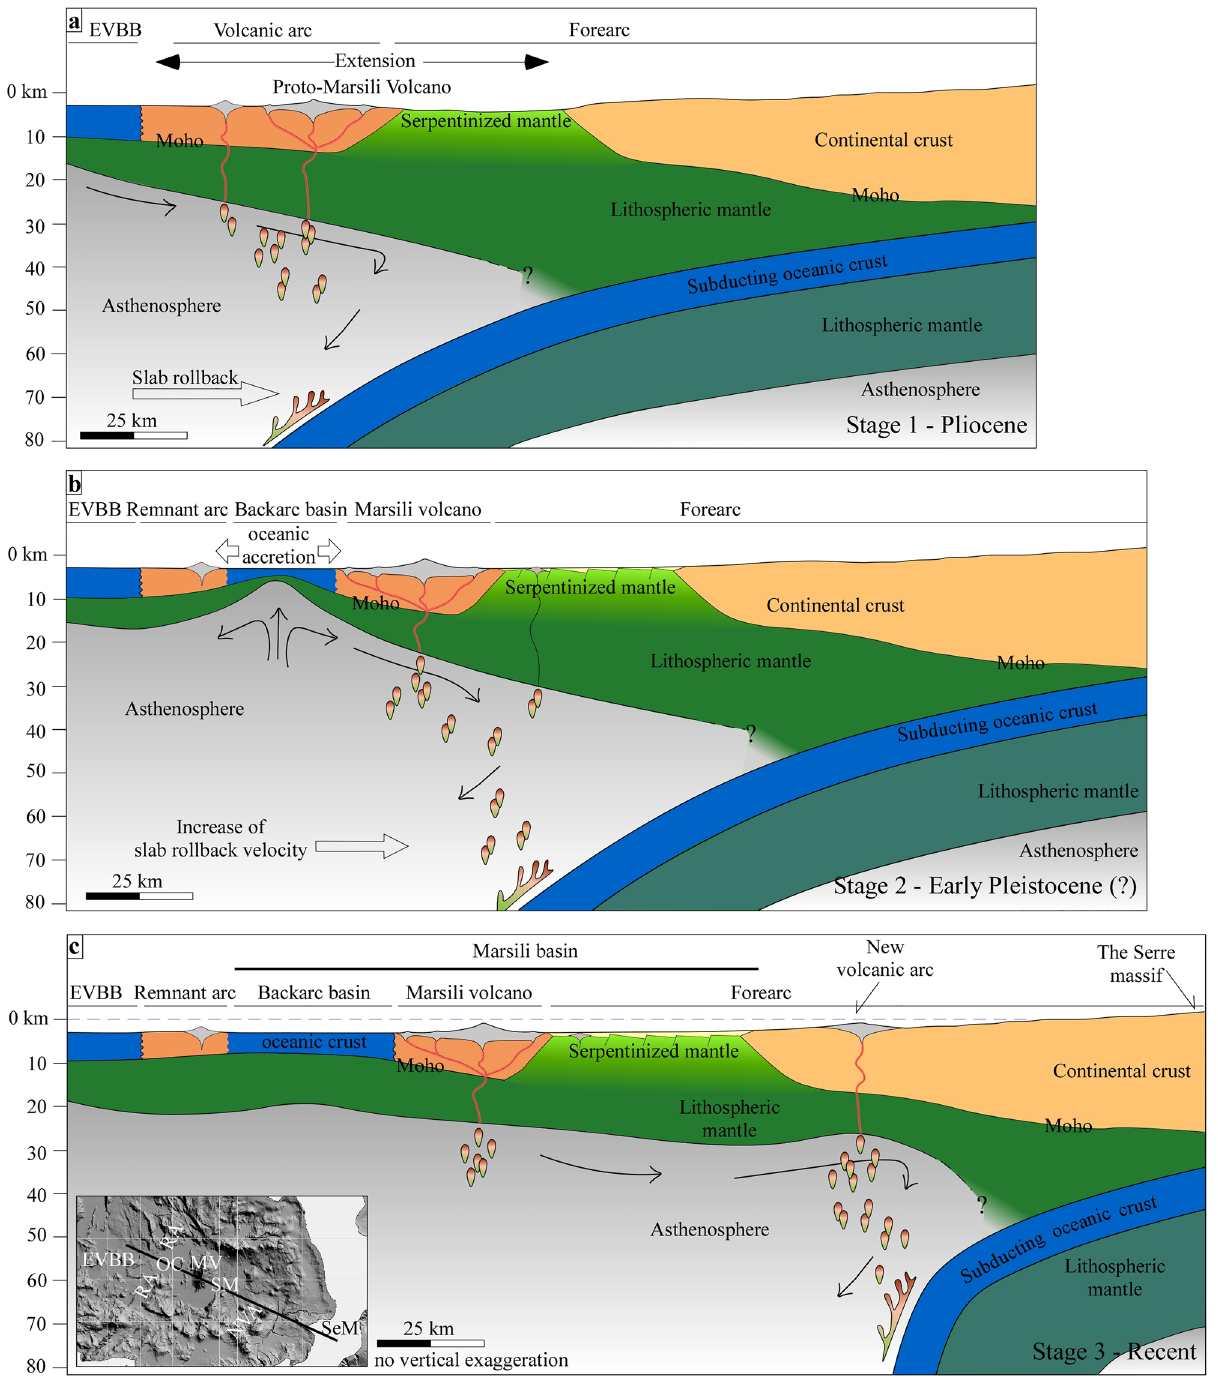
Figure 4. Evolutionary model of the Marsili basin. ( a ) Extensional deformation in the volcanic arc and forearc regions. ( b ) Arc rifting and oceanic accretion in the backarc basin. ( c ) Development of the new volcanic arc in the forearc domain. The depth of the Moho discontinuity and the lower plate derived from literature data 4,34,65–67 . Inset shows the location of the section. EVBB: eastern Vavilov backarc basin, MV: Marsili volcano, NVA: new volcanic arc, OC: oceanic crust, RA: remnant arc, SeM: Serre massif, SM: serpentinised mantle. The inset map was generated using the GeoSuite AllWorks software package (version 2021R2, https:// www. geoma rines urvey syste ms. com/ downl